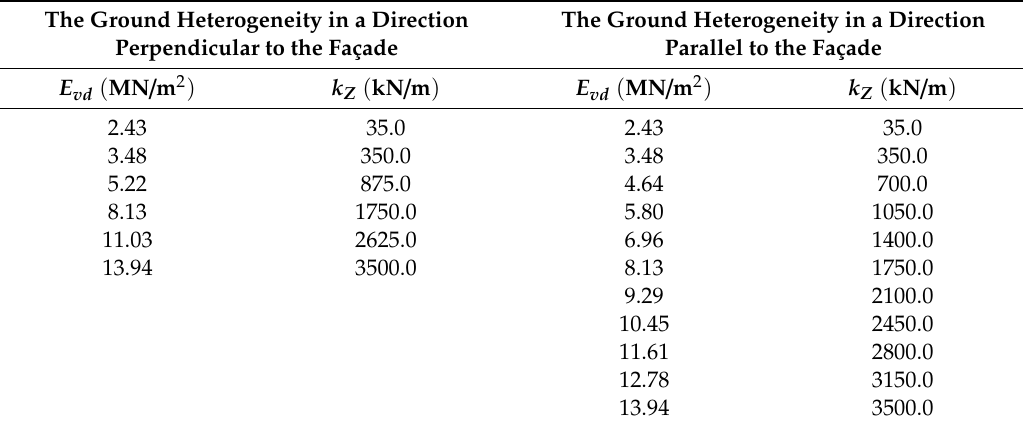
Table 2. Values of dynamic modulus E vd and respective sti ff ness of support k Zmin . The Ground Heterogeneity in a Direction Perpendicular to the